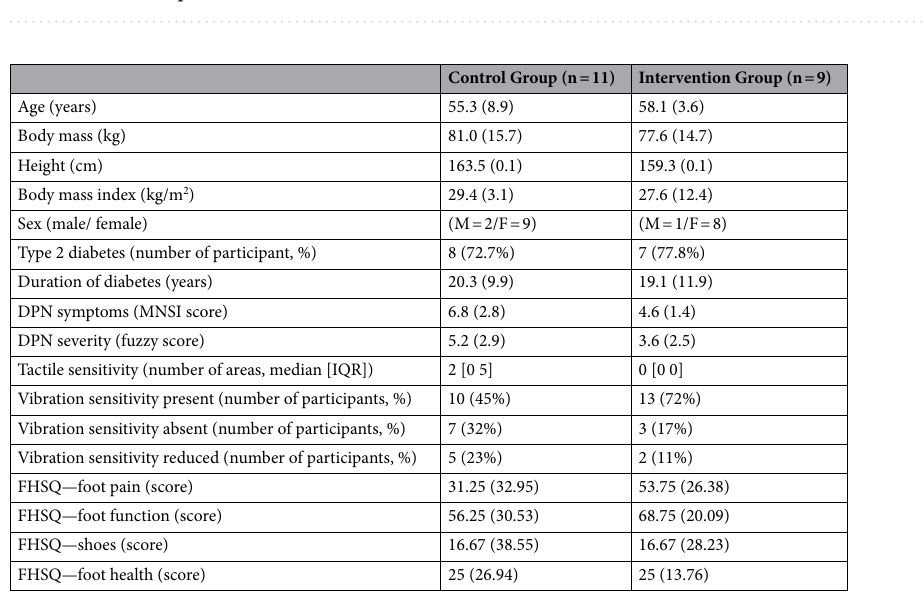
Figure 2. Exercise dose. The general exercise progression from all IG participants from each session (columns) and the volume (repetitions) (blue line) of total workout exercises.